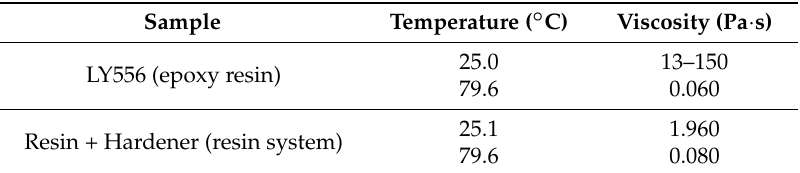
Table 11. Viscosity of resin system at different temperatures.